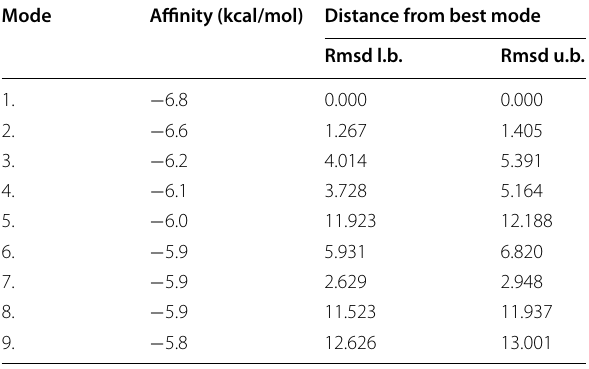
Table 2 Results of the docking analysis in Autodock Vina for halogenated boroxine and human carbonic anhydrase Mode Affinity (kcal/mol) Distance from best mode Rmsd l.b. Rmsd